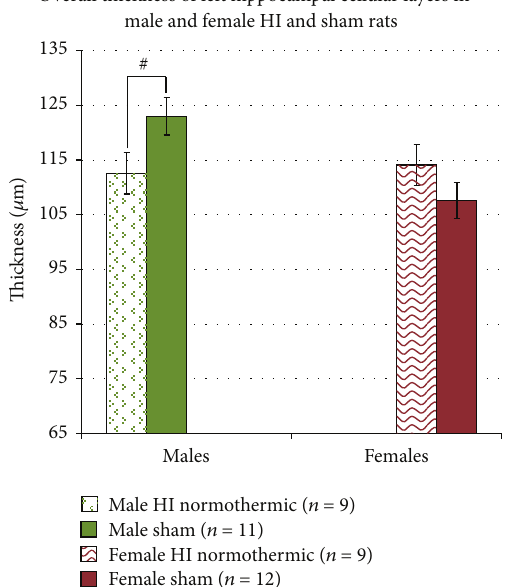
Figure 3: A 2 (Sex) × 2 (Treatment) ANOVA revealed a trend for a significant Sex effect ( 𝑝 = 0.06 ) and a significant Sex × Treatment interaction ( 𝑝 < 0.05 ). Individual independent samples 𝑡 -tests for each sex separately revealed a trend for HI male normothermic animals to have significantly thinner hippocampal cellular layer thickness ( # 𝑝 = 0.077 ), but HI female normothermic animals were revealed to have thicker hippocampal cell